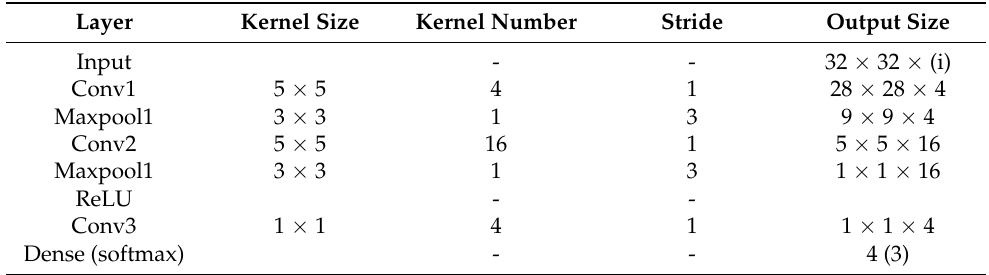
Table 1. Configuration of Nez CNN model. (i) is the number of input bands. We classified into 4 or 3 disturbance